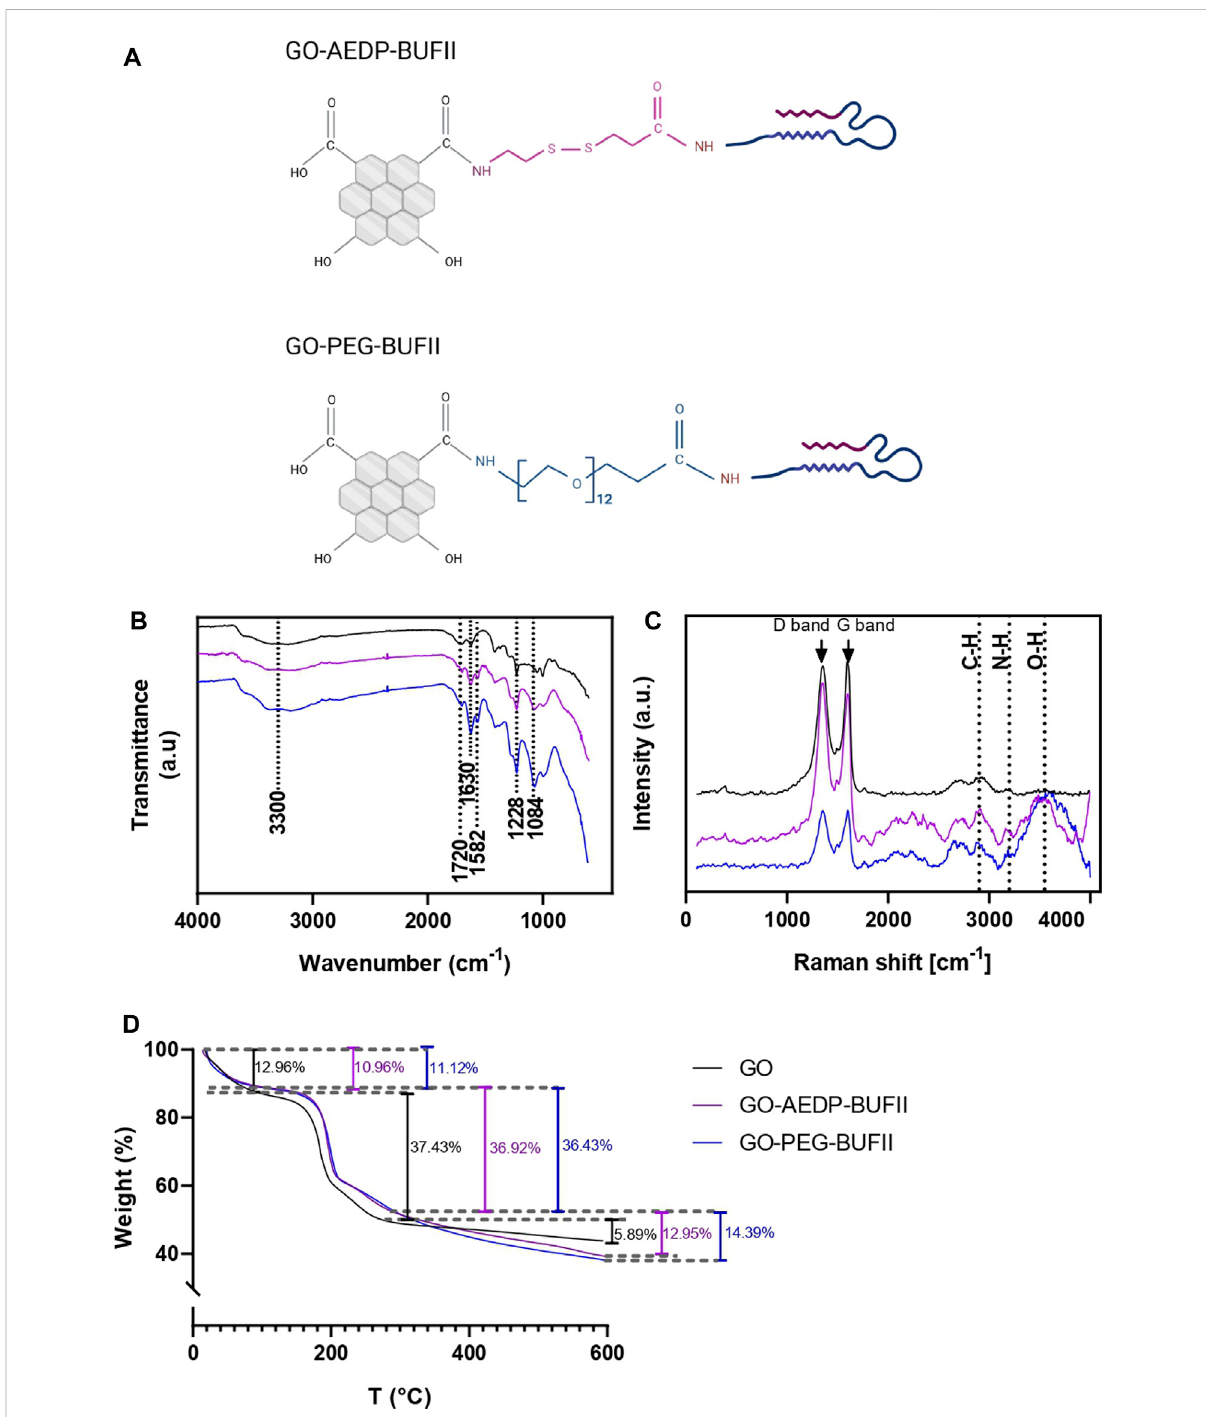
FIGURE 2 Characterization of the GO-AEDP-BUFII and GO-PEG-BUFII. (A) Schematic of the chemical structure of the developed nanobioconjugates. Theobtentionofthesenanobioconjugates wassuccessfully corroborated via: (B) FTIRspectralanalyses; (C) Ramanspectroscopicanalyses; (D) TGA pro fi